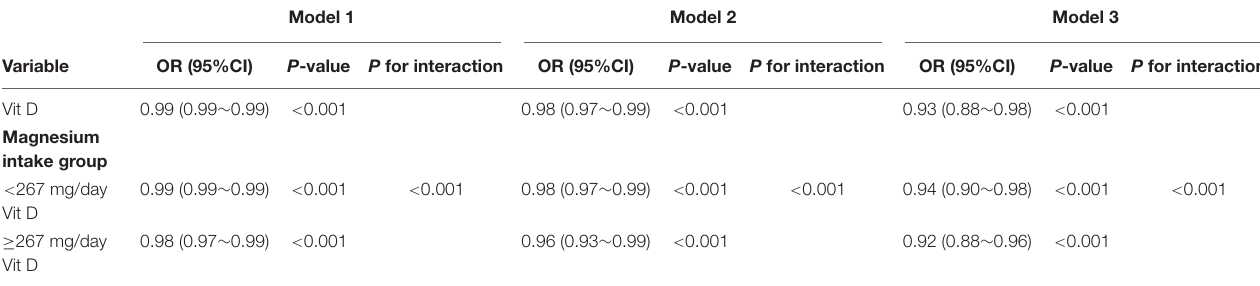
TABLE 3 | Interactive effect of vitamin D and dietary magnesium intake on IR (All participants).